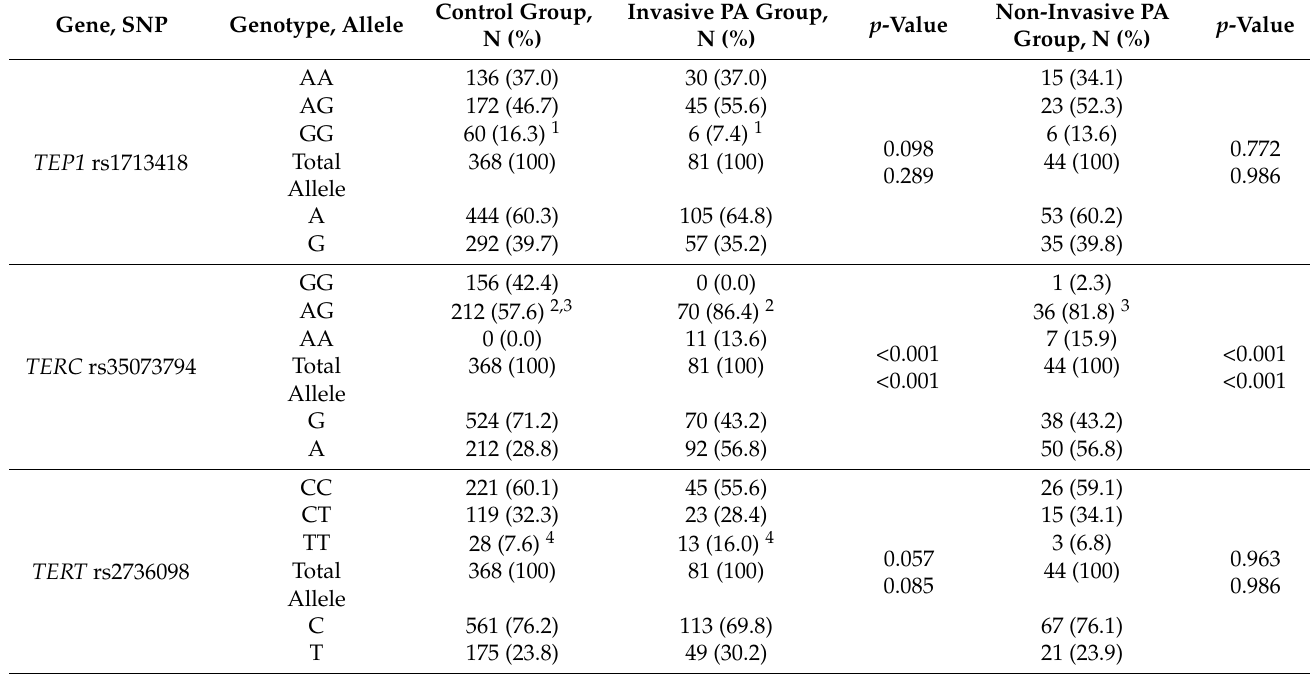
Table 6. TEP1 , TERC , and TERT genes single nucleotide polymorphisms frequencies of genotypes and alleles within invasive or non-invasive pituitary adenoma and control